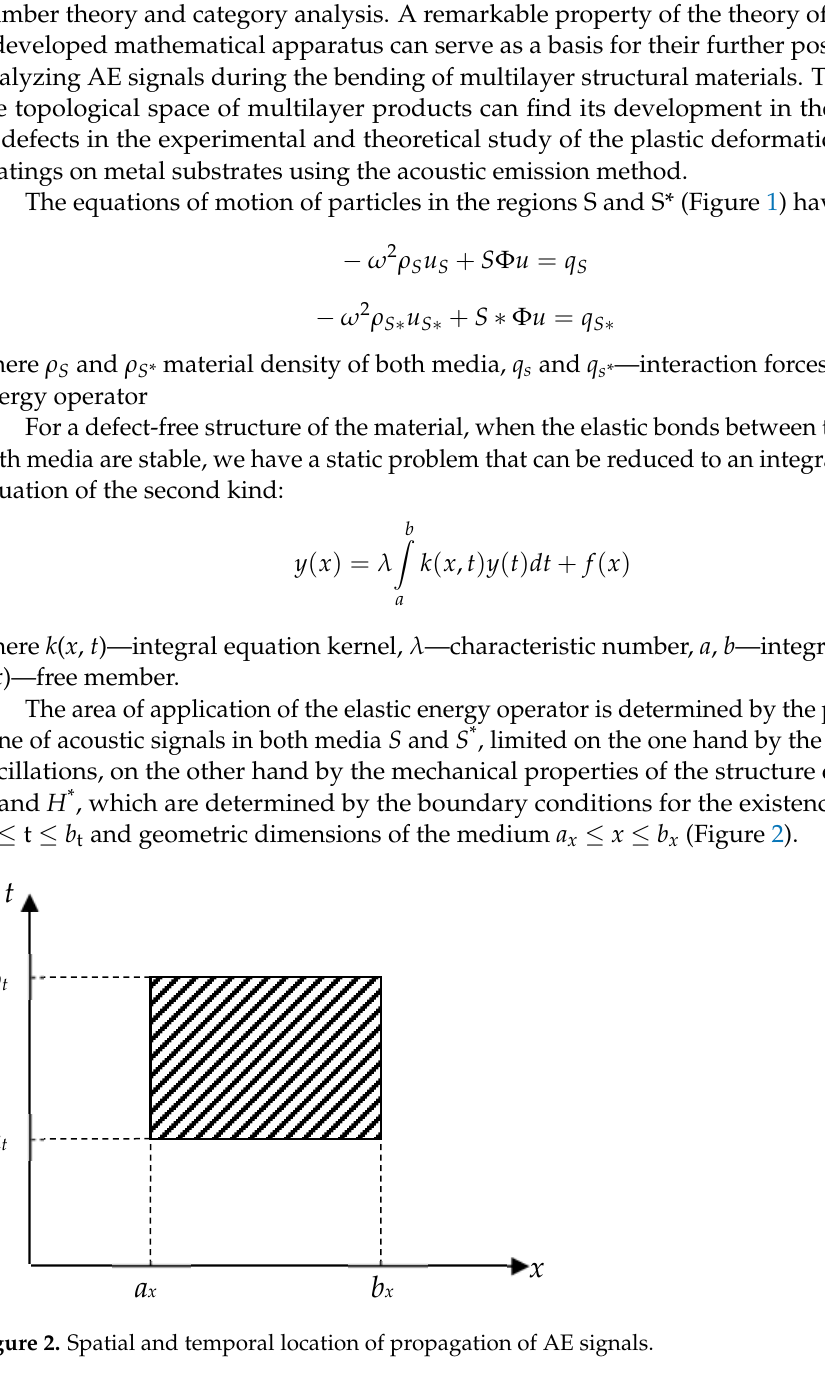
Figure 2. Spatial and temporal location of propagation of AE signals. Aggregate λ determines the energy spectrum of the elastic energy operator. Value y ( t ) characterizes the receiving signal, and y ( x )-triggered signal. The solution of the boundary value problem of the structure of the energy spectrum of the AE signal is given by the formula